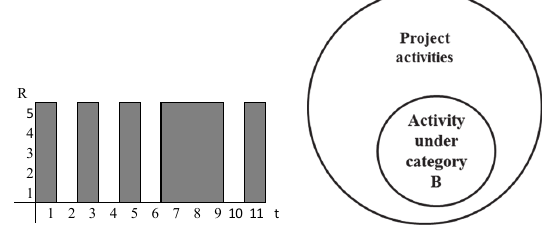
Fig. 3. An example of activity classified under category B